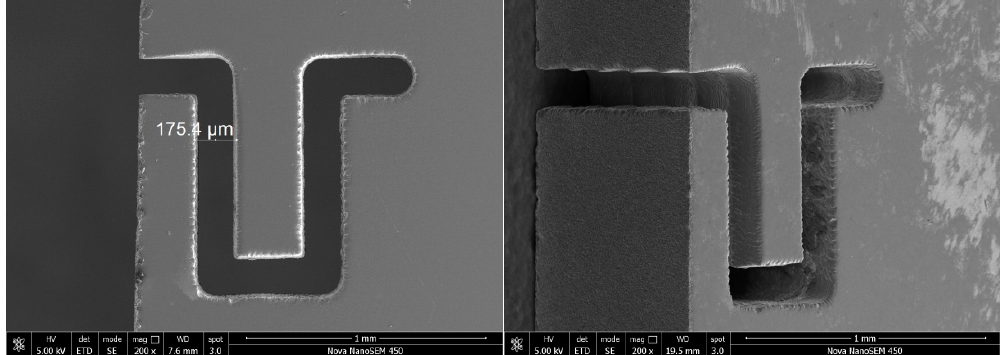
Figure 17. High aspect ratio structure on 1060 μ m thick glass.